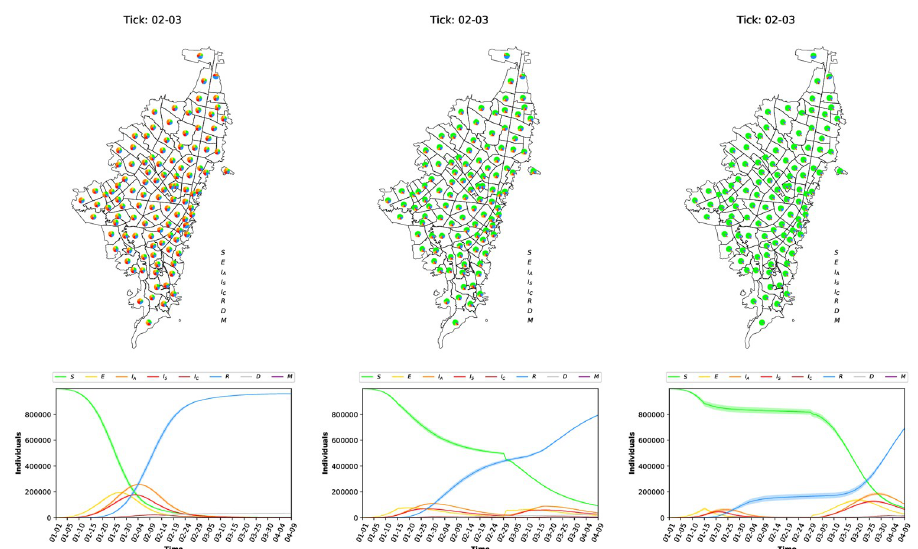
Fig 6. Social distancing after 100 days when initialized at day 15 and ended at day 60 of the simulation. None—No restrictions (left), Medium—close 40% of places (middle), and Extreme—close 80% of places